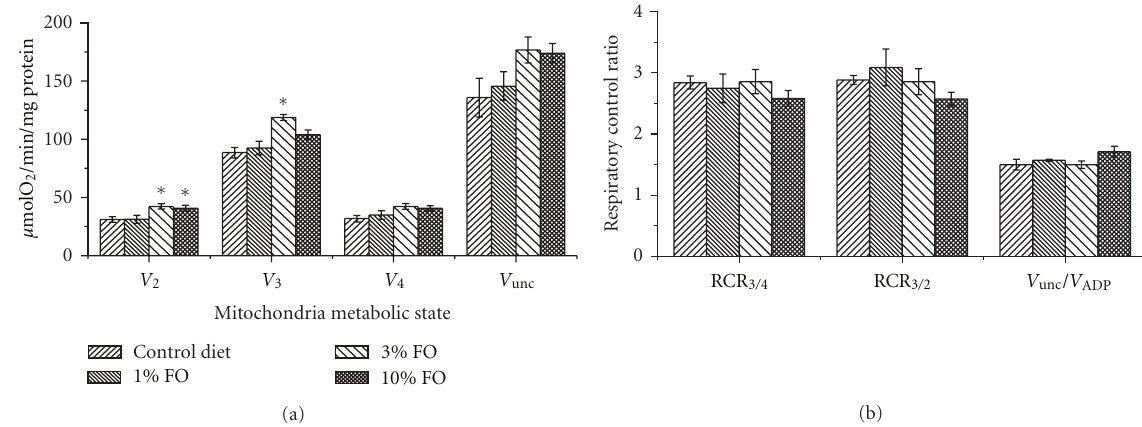
Figure 5: Omega-3 PUFA enriched diet does not a ff ect liver mitochondria respiratory parameters. Respiratory parameters were measured in di ff erent metabolic states state 2 ( V 2 ), state 3 ( V 3 ), state 4 ( V 4 ), FCCP-stimulated respiration ( V unc ). (a) 5mM succinate +1 μ M rotenone (1 μ M) was used to stimulate respiration initiated at complex II; (b) The e ff ect of diets on RCRs measured on succinate + rotenone. The data are expressed in μ mol O 2 /min/mg protein and are the mean ± SEM, n = 6. Statistical significance in oxygen consumption between tested samples was determined by a two-sample t